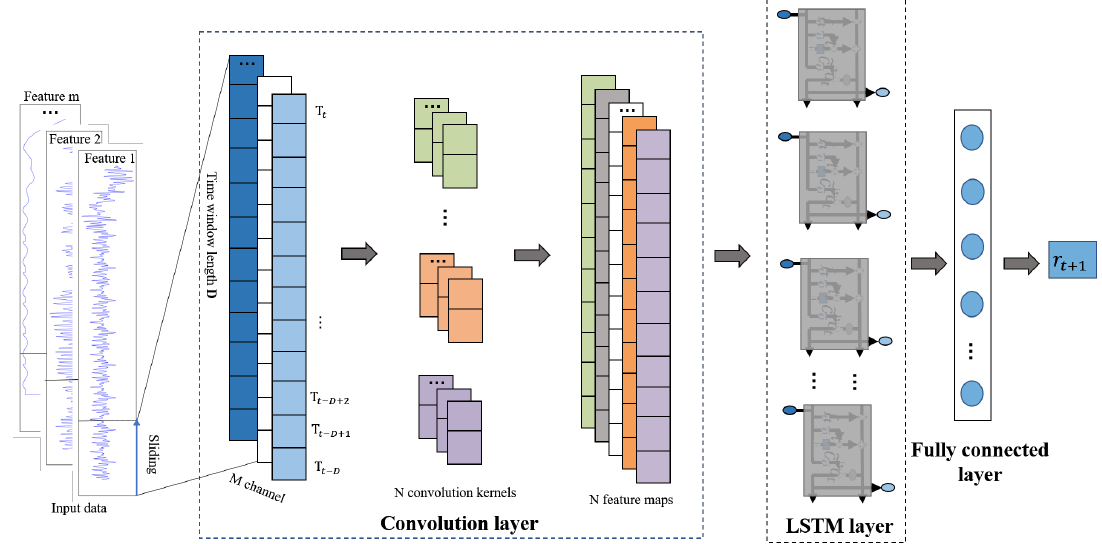
Figure 1. Framework of the proposed coupled convolutional neural network (CNN) and long short-term memory (LSTM) prediction